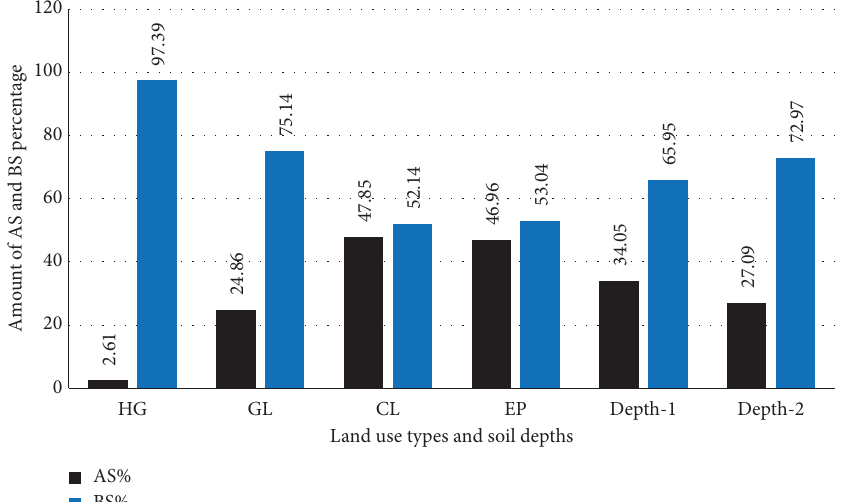
Figure 3: Comparison of acid saturation percentage with base saturation percentage under diferent land use types and